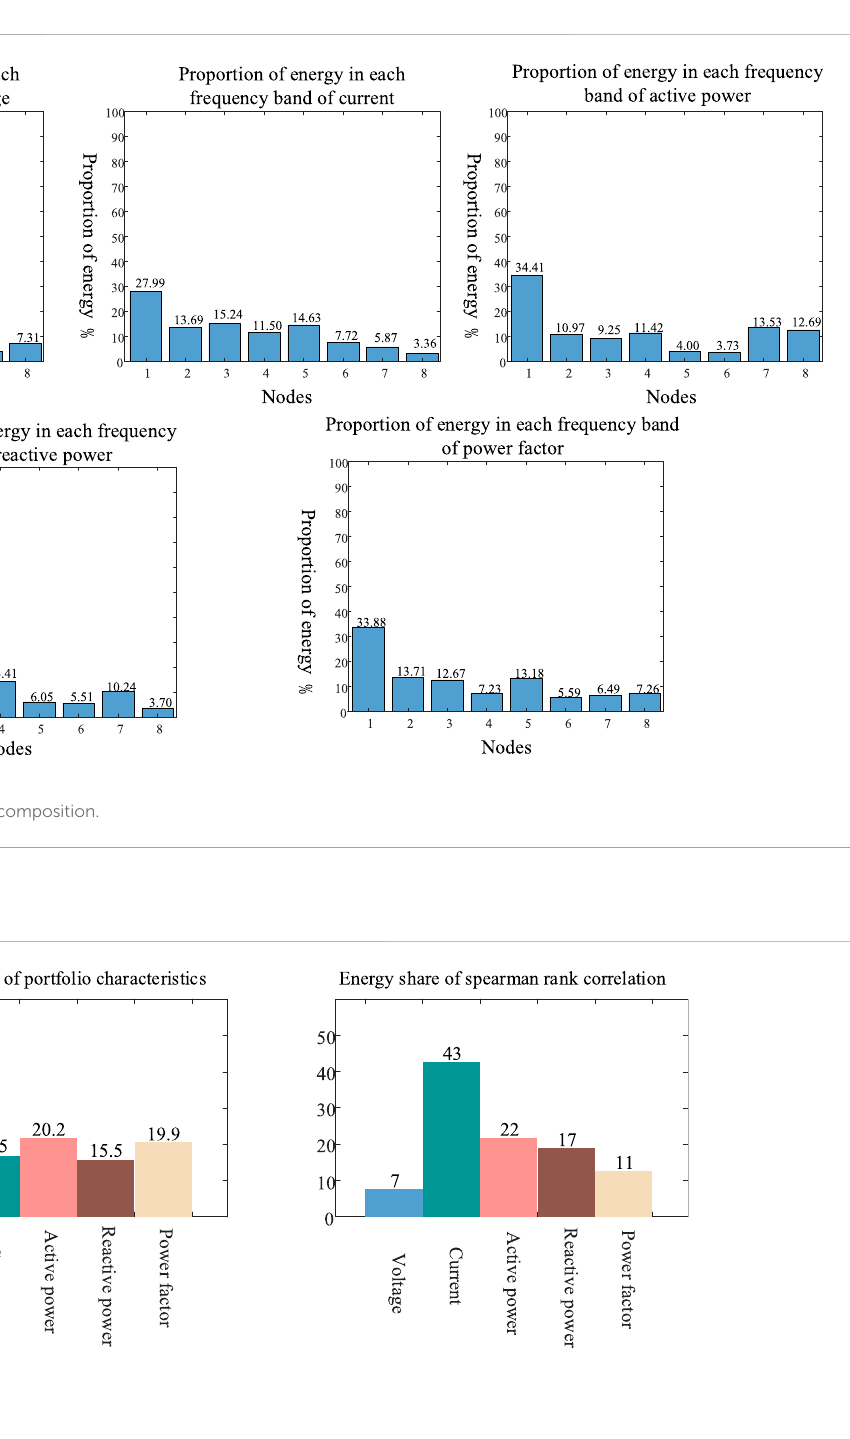
FIGURE 6 Comparison of energy